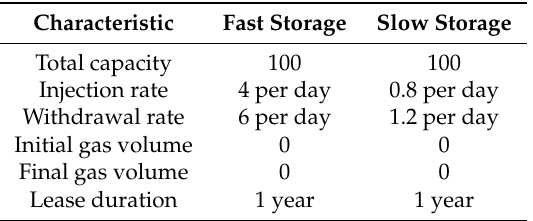
Table 4. Gas storage characteristics (fast and slow